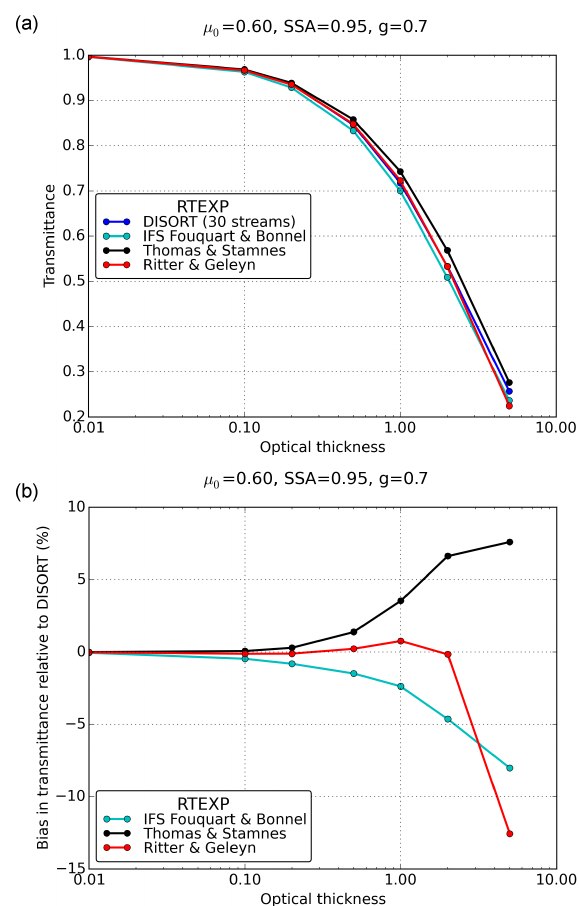
Figure 8. (a) Transmission as a function of optical depth through a homogeneous atmospheric layer containing aerosol (SSA = 0.95, g = 0 . 7, cosine of the solar zenith angle set to 0.6) for the follow- ing radiative transfer algorithms: IFS Fouquart and Bonnel (1980) clear-sky radiative transfer formulation (cyan curve), the Thomas and Stamnes (2002) two-stream approximation used for aerosol transmittance in hlradia (black curve), the Ritter and Geleyn (1992) two-stream approximation used in acraneb2 (red curve) and the ac- curate 30-stream DISORT (Stamnes et al., 1988) radiative transfer scheme (blue curve). Panel (b) is the same as panel (a) but shows the transmission differences relative to the accurate DISORT